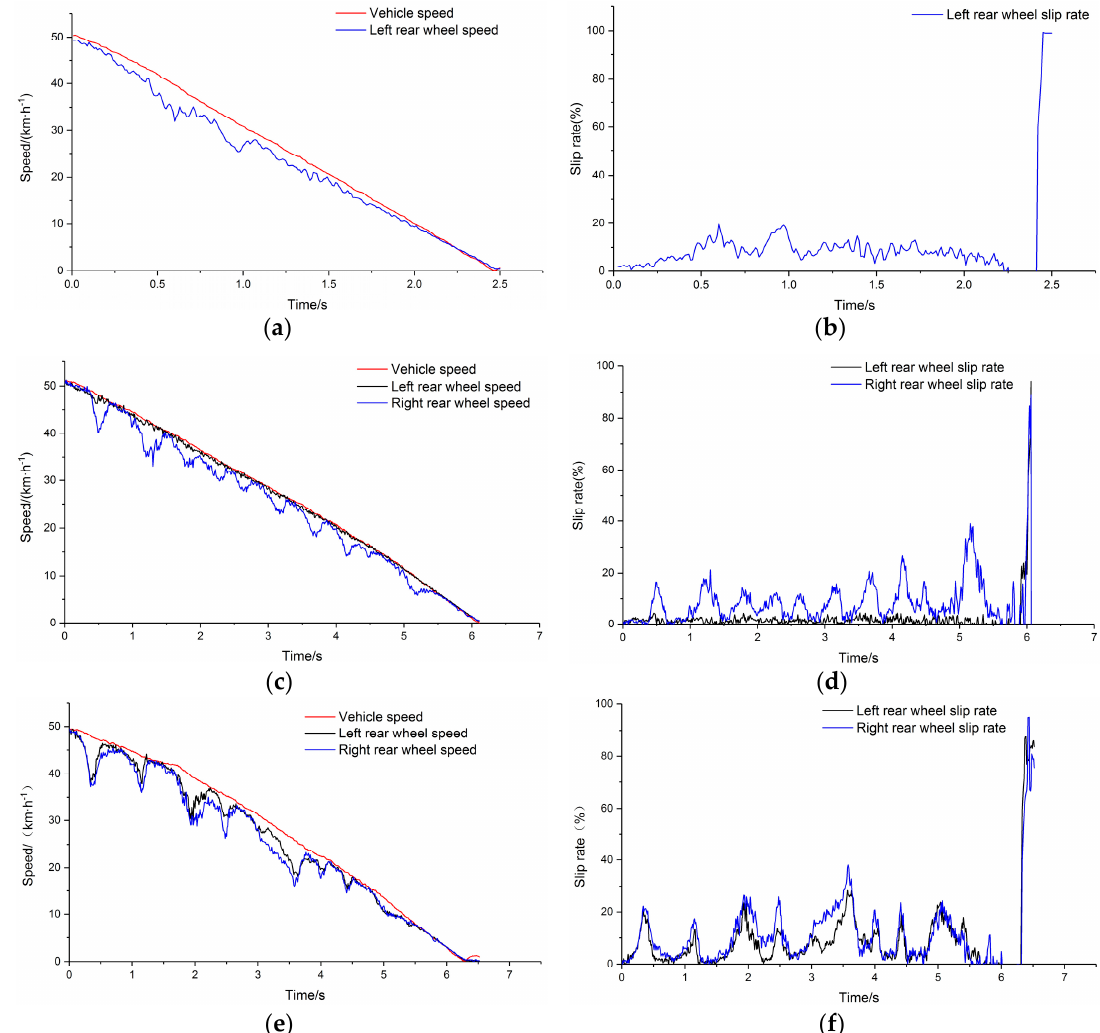
Figure 21. ( a ) Comparison of vehicle speed and speed of four wheels with high adhesion road; ( b ) slip rates with high adhesion road; ( c ) vehicle speed and speed of four wheels with bisectional road; ( d ) slip rates with bisectional road; ( e ) vehicle speed and speed of four wheels with low adhesion road; ( f ) Slip rates with low adhesion road.